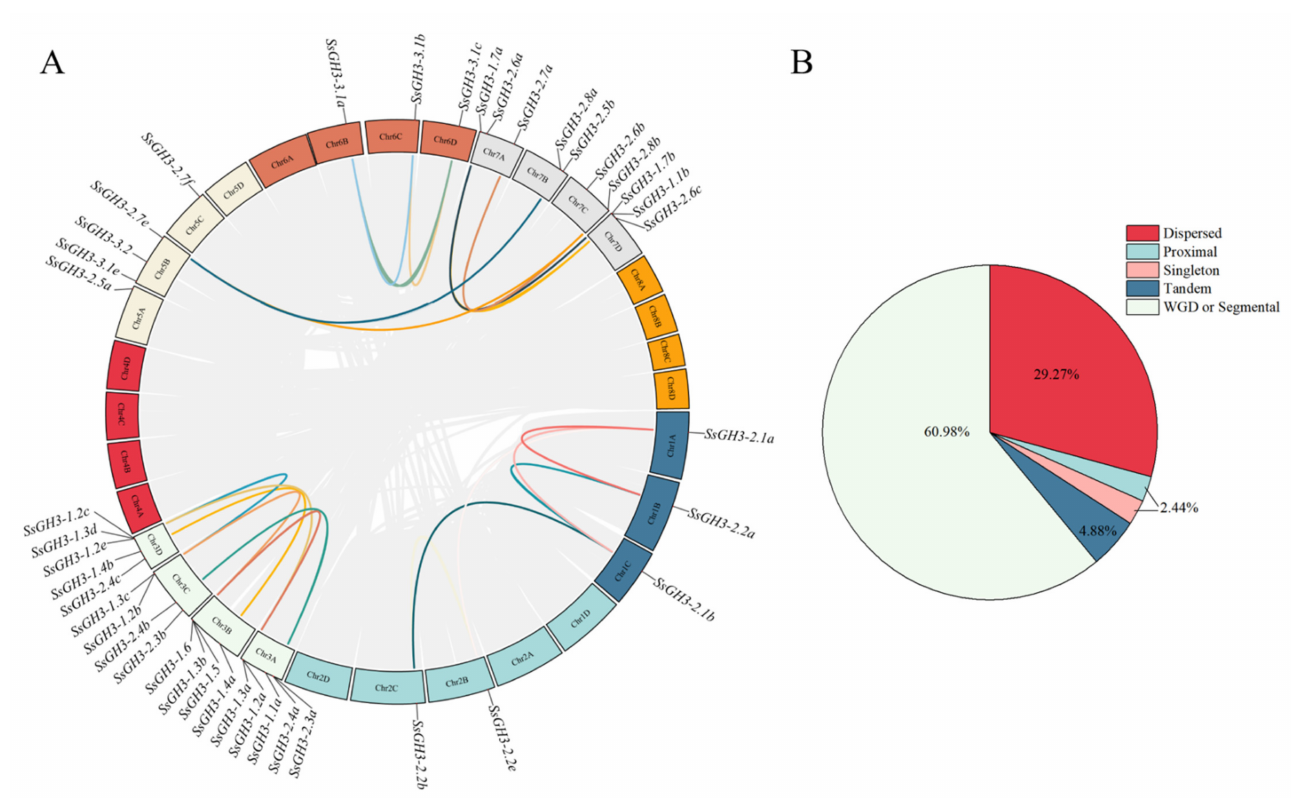
Figure 3. Synteny analysis ( A ) and expansion mechanisms ( B ) of the SsGH3 family gene. The grey lines represent all the genes that have been replicated in the genome; the different colored lines represent the SsGH3 genes that have been replicated. Different colors in the pie chart represent different types of gene duplication. WGD or segmental, whole-genome duplication/segmental duplication; Dispersed, dispersed duplication; Proximal, proximal duplication; Tandem, tandem duplication; Singleton, singleton